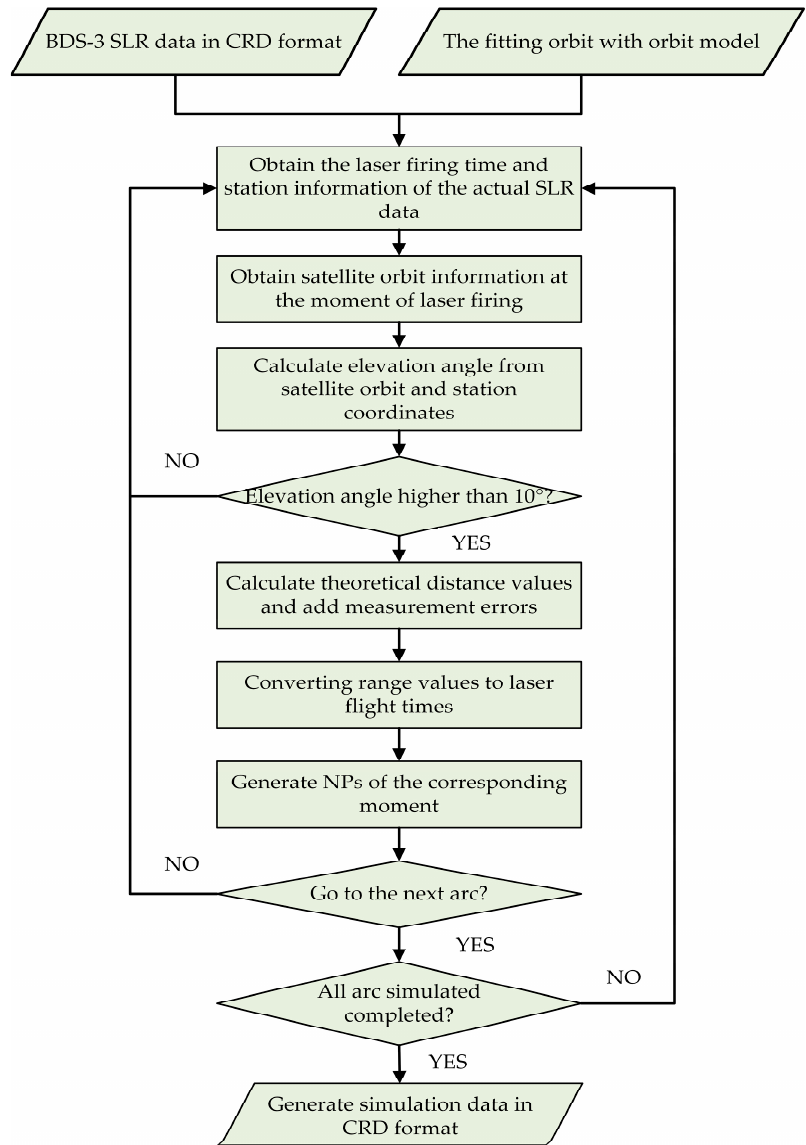
Figure 9. The simulation process of SLR data based on actual observations.